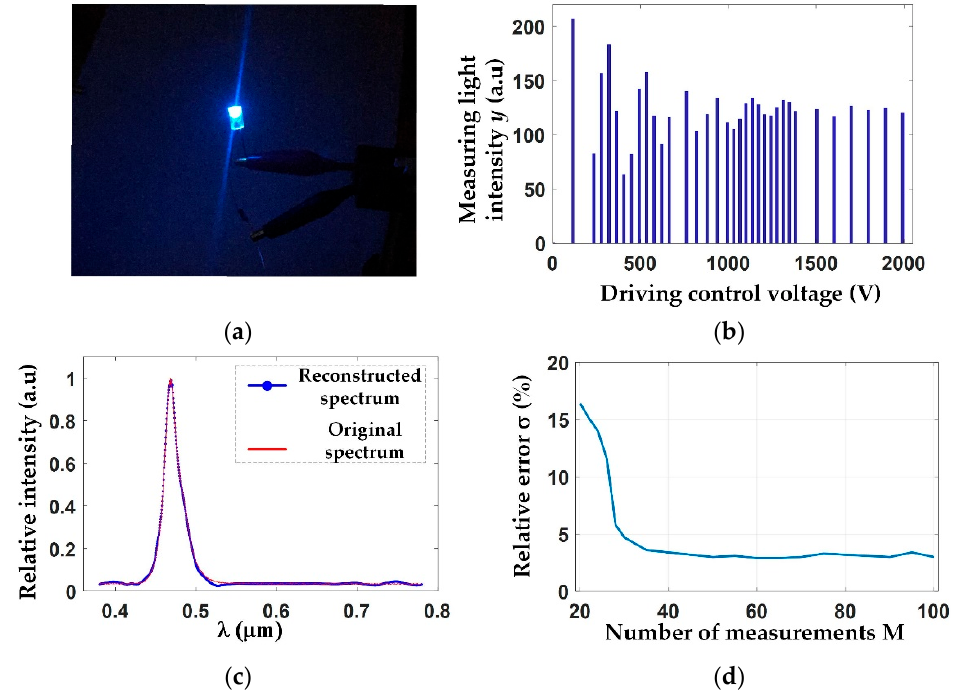
Figure 6. Blue LED light source spectrum measurement: ( a ) Blue LED; ( b ) Compressed measure- ment signal; ( c ) Reconstructed spectrum signal; ( d ) Relative error with different number of measurements from 20 to 100.